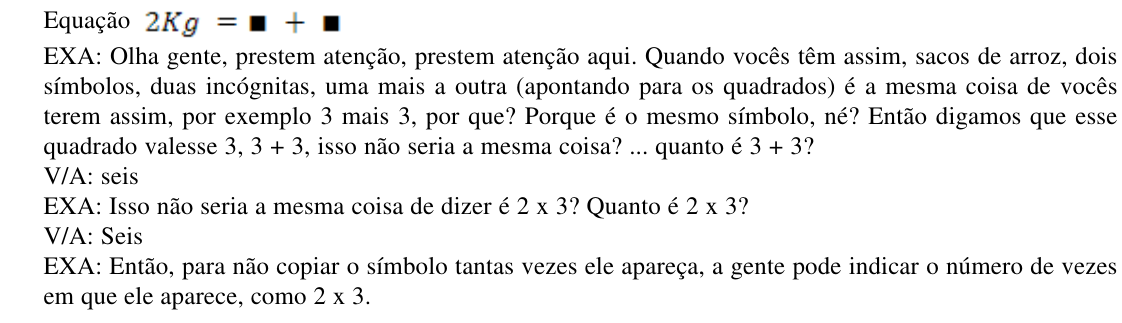
Figura 1. Diferença entre coeficiente da incógnita e um valor conhecido qualquer Notas. Legenda: EXA = examinadora; A = um aluno apenas; V/A = vários alunos; ... indica murmúrio indecifrável e as palavras em parênteses referem-se à ação dos sujeitos, ou comentários para exemplificar o ocorrido. Mostrar que para Retirar os Termos dos Membros da Equação é Necessário Realizar Operações Inversas Como mostra o episódio abaixo: